Question: Provide a one-line summary of what is displayed.
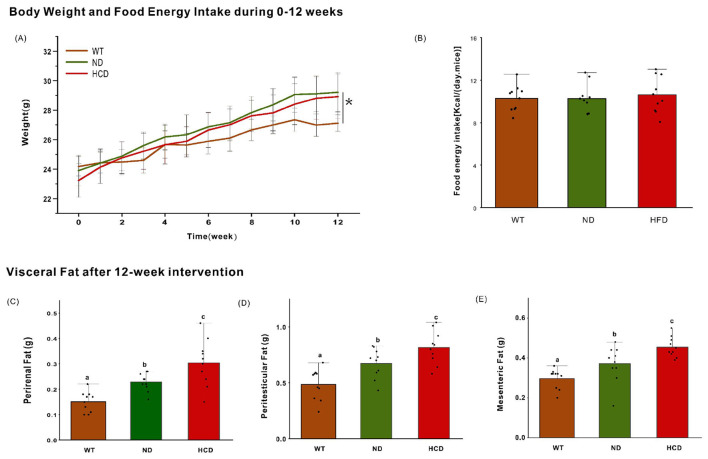
Answer: Body Weight, Food Intake Energy and Visceral Fat. (A) Body weight during 0–12 week; (B) Average daily food energy intake per mouse; (C–E) Visceral fat after 12-week intervention: (C) Perirenal fat; (D) Peritesticular fat; (E) Mesenteric fat. The difference between values with completely different superscripts was statistically significant, P < 0.05. Data are means ± SD ( n = 10). * denotes statistically significant differences between groups.